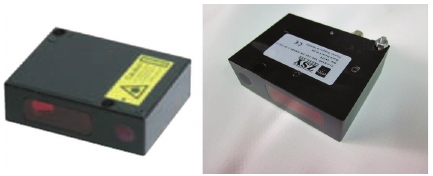
Figure 3: The ZLDS100 laser displacement sensor.